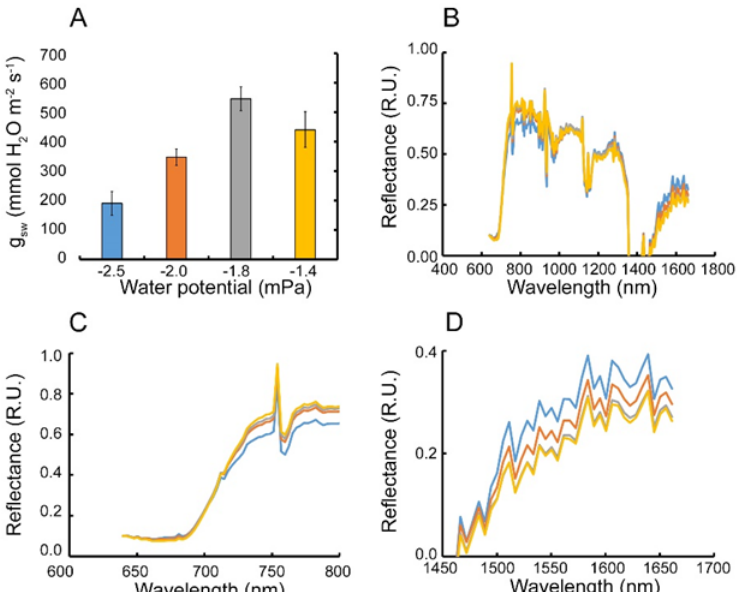
Figure 3. An example of data acquired in the study (in this example, 2 July 19 at 10:30). ( A ) Averaged values of stomatal conductance g sw in (mmol H 2 O m − 2 s − 1 ). N = at least four independent samples and error bars represent standard error of the mean. Color scheme in this figure corresponds to the four water potential treatments, where yellow, grey, light brown, and blue represent the water potential readings − 1.4, − 1.8, − 2.0, − 2.5 MPa. ( B ) Reflectance signature of cotton at four water potential treatments. ( C , D ) Magnification of spectral reflectance where there is a correlation between spectra magnitude and water potential treatments. Panels ( B – D ) were smooth-averaged with an 11-pace window for the qualitative purpose of presentation.